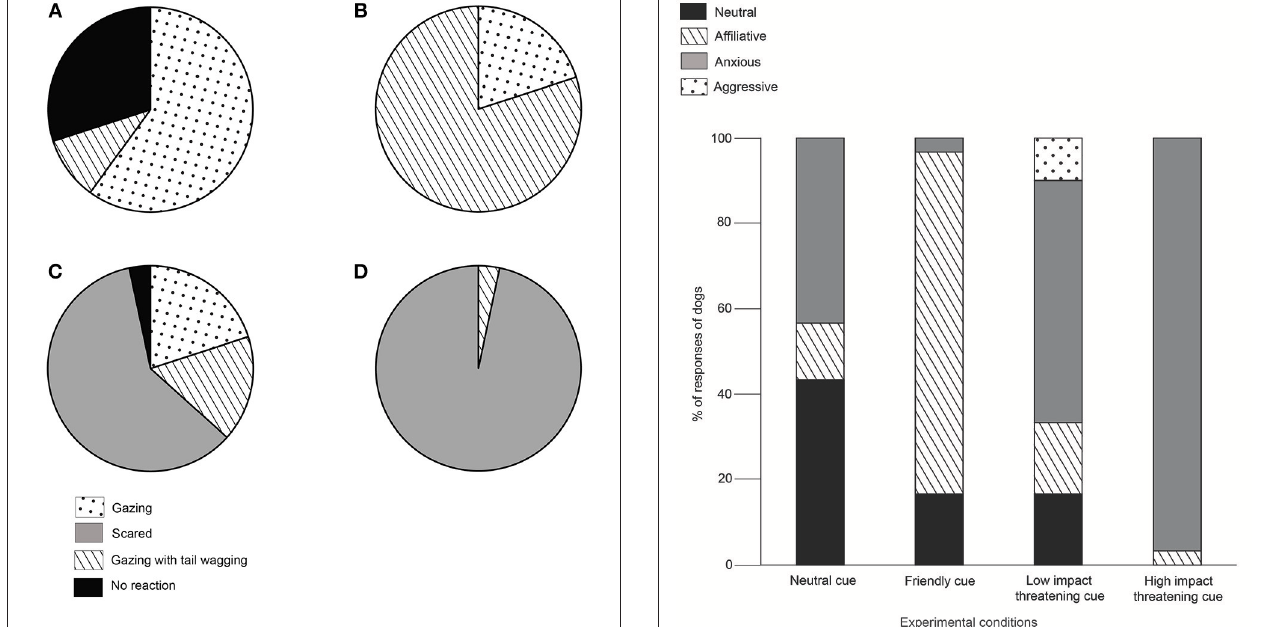
FIGURE 3 | First reaction to social cue. Pie charts showing the first reaction (behaviors) to social cues. (A) Distribution of behavioral responses in NC condition, (B) Distribution of behavioral responses in FC condition, (C) Distribution of behavioral responses in LIT condition, (D) Distribution of behavioral responses in HIT condition.